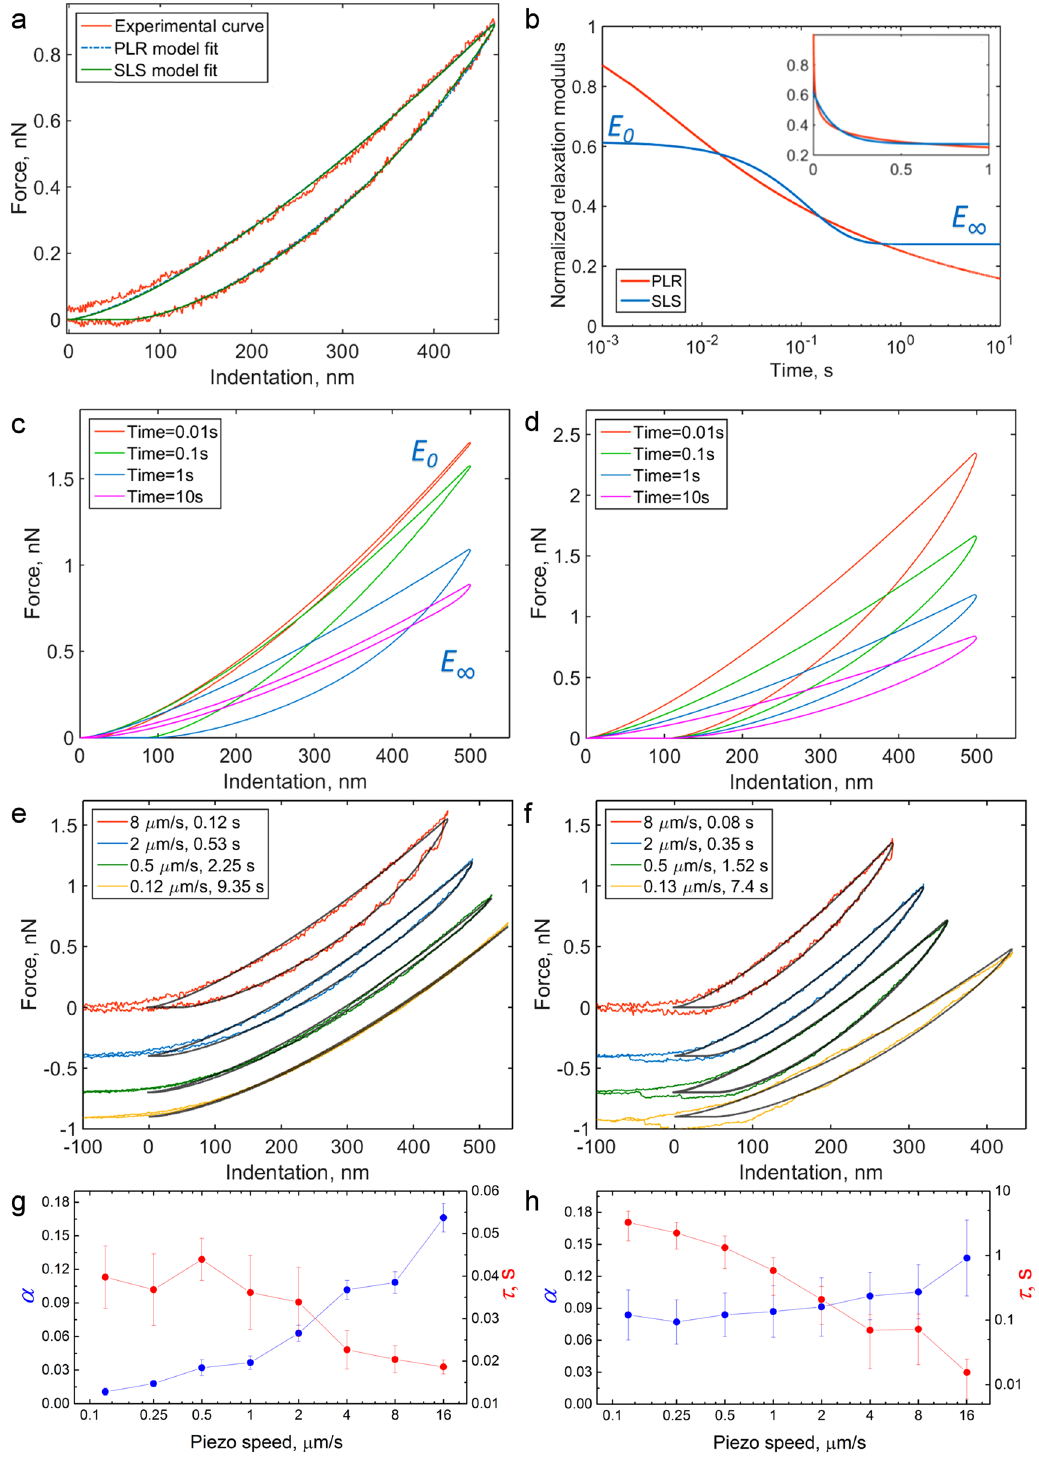
Figure 3. Comparison of SLS and PLR models in experiments with PAAm hydrogels and NIH 3T3 fibroblasts. ( a ) Experimental F- δ curve obtained on a fibroblast with both PLR and SLS model fits. ( b ) Normalized relaxation functions for PRL and SLS models with adjusted parameters on a logarithmic scale, inset – same functions on a linear scale. ( c,d ) Modelled F- δ curves with different indentation times. Left – SLS ( τ = 0.1 s), right – PLR ( α = 0.15). ( e,f ) Experimental F- δ curves obtained on PAAm hydrogel (left) and fibroblast (right) with different indentation times. The offset is added to the force for clarity. Black lines are SLS ( e ) or PLR ( f ) model fits. ( g,h ) Viscoelastic parameters α and τ for PAAm hydrogels (left, combined data for experiments on 3 gels, mean ± s.d.) and NIH 3T3 fibroblasts (right, combined data for experiments on 12 cells, mean ± s.d.) as a function of piezo displacement